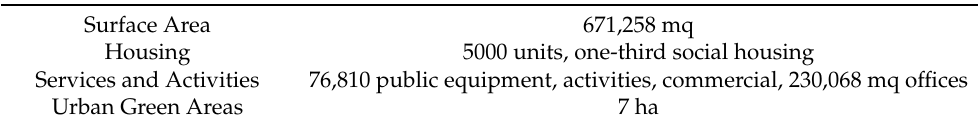
Table 12. The project. Source: Authors’ elaboration (2022) based on data from the site http://www. ecoquartiers.logement.gouv.fr (accessed on 19 June